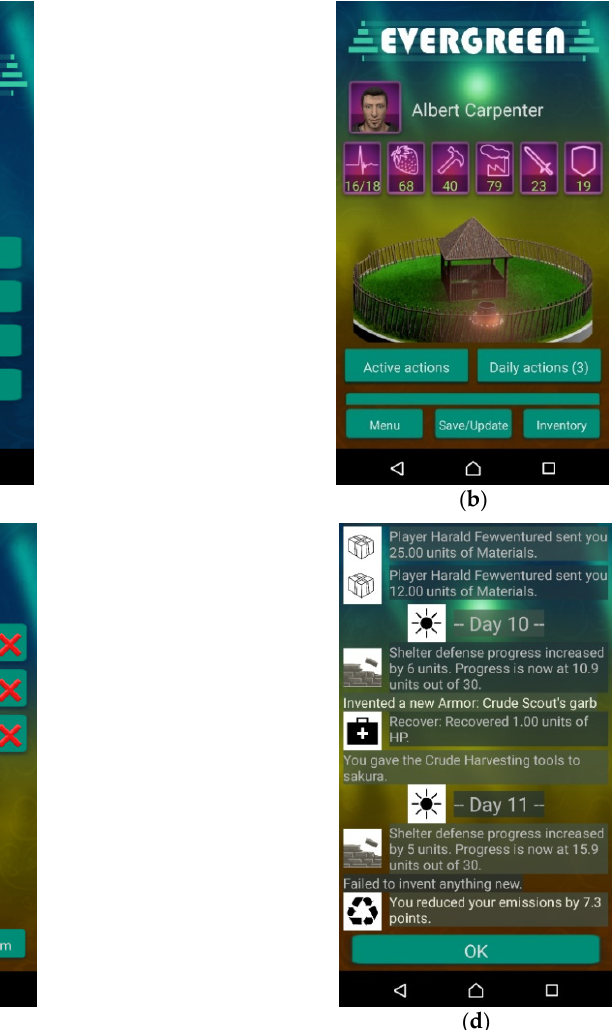
Figure 8. Early design stages of the Evergreen persuasive game. ( a ) First page of the initial paper prototype (11 pages in total) [51]. ( b ) Early design of the game’s splash screen. ( c ) Early design of the game’s main screen showing player statistics in the top, buttons for actions, and a log of what has happened previously. ( d ) Early design of the results screen, which is displayed after each new day.